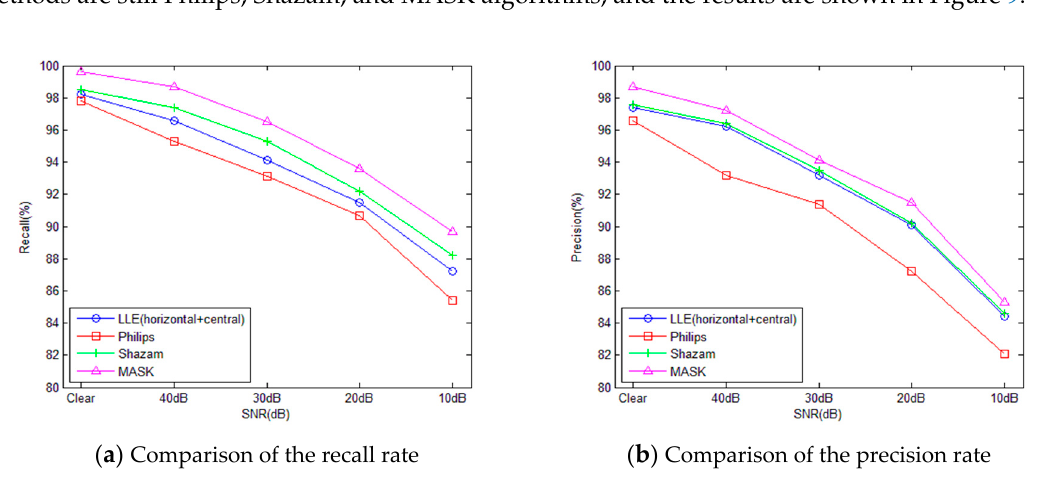
Figure 9. Comparison of multiple reduction with other methods.